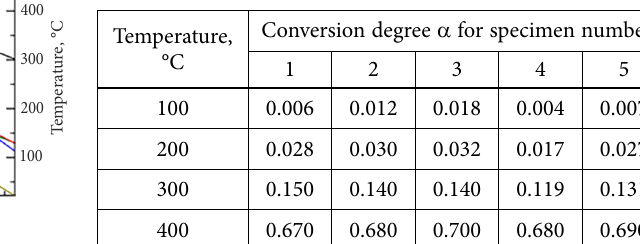
Table 2. Calculation of the conversion degree of different GFRP rod elements